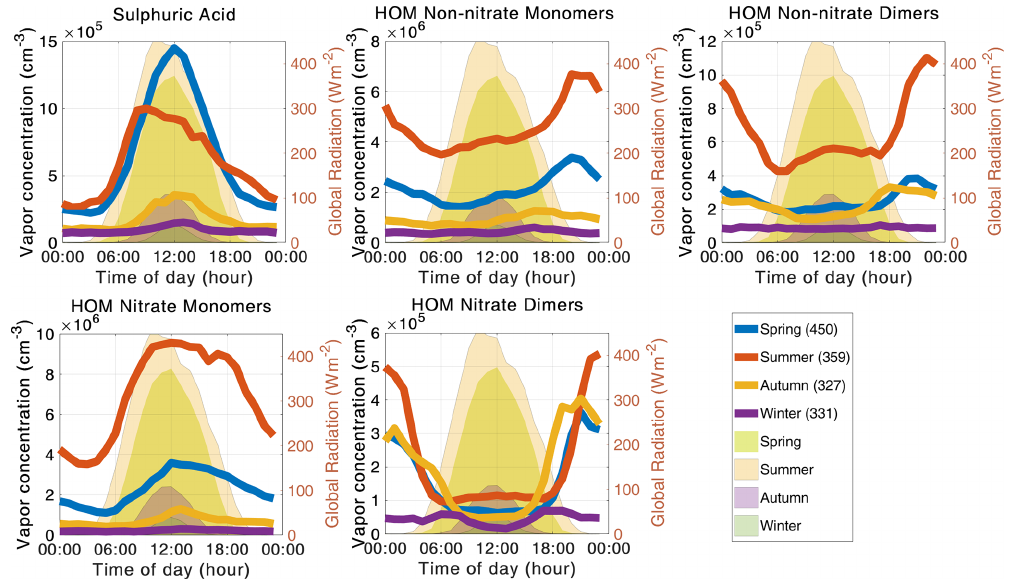
Figure 11. The diurnal cycles of precursor vapors in different seasons. The number of days included in the median day is presented by the number in parentheses in the legend. The light green, light yellow, lilac, and dark green shading represent spring, summer, autumn, and winter, respectively.